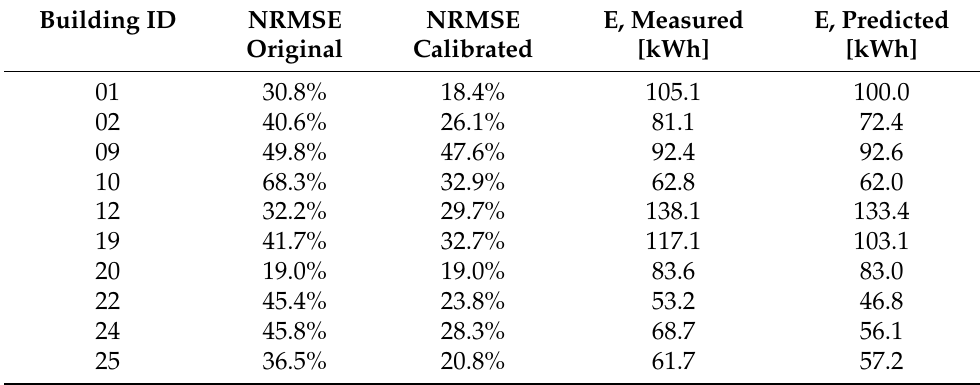
Table 6. Model prediction error after calibration.